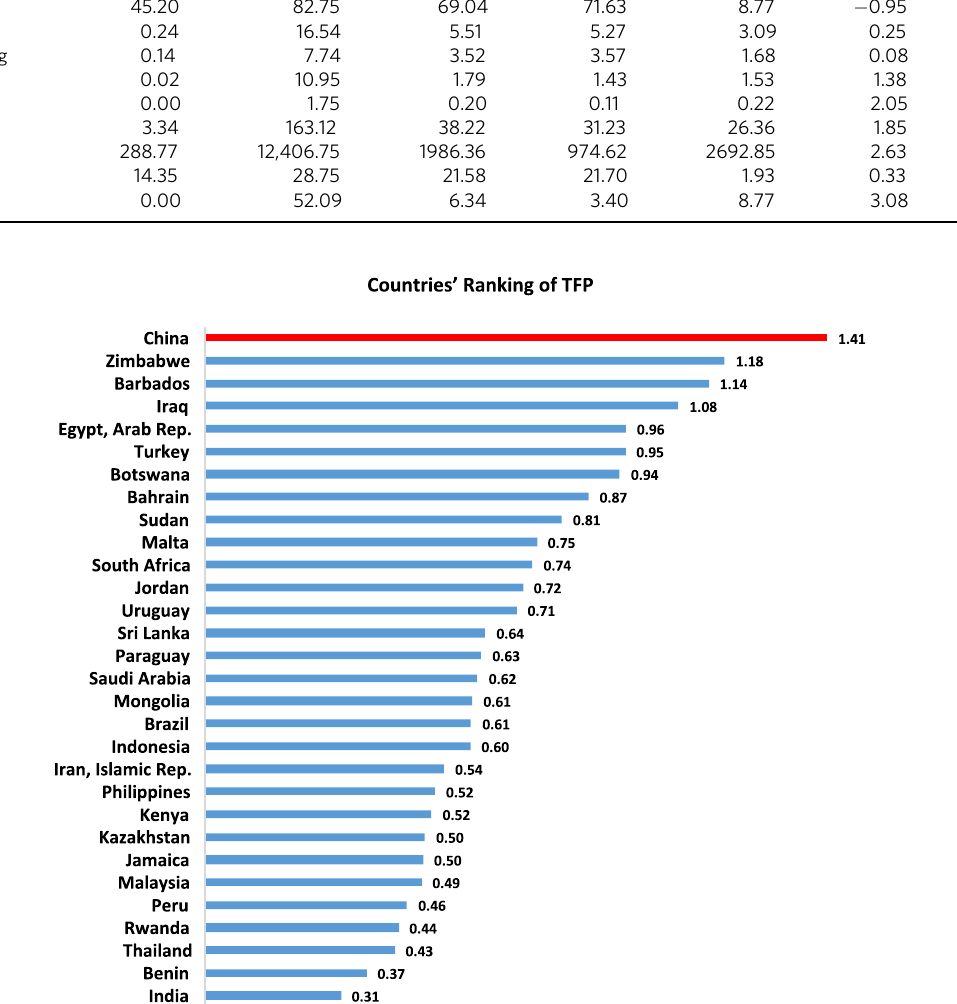
Fig. 1 Average Total Factor Productivity. Ranking of average total factor productivity of selected 30 emerging economies in descending order from the years (1990 − 2019). China has the highest while India has the lowest average total factor